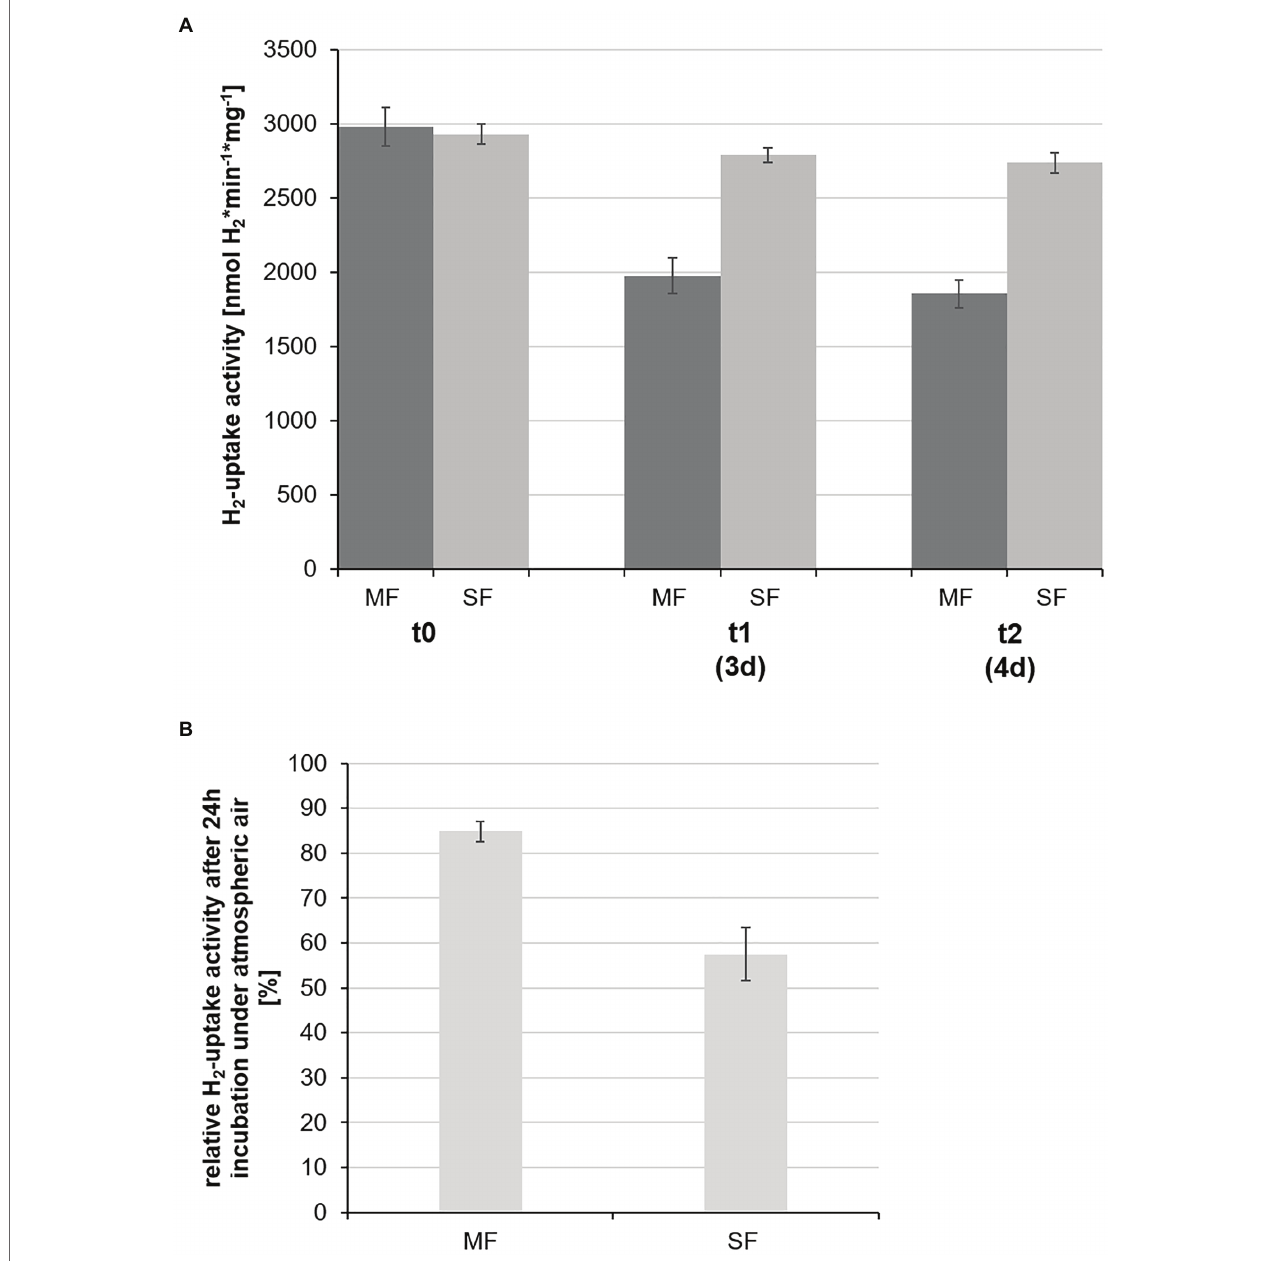
FIGURE 6 | Specific hydrogen uptake activities of the soluble (SF) and membrane (MF) protein fractions of strain KaireiS1. The measurements at the different time points (0, 3, and 4 days) were carried out using the same protein extracts, stored under oxygen-free conditions at 4 ° C (A) . The stability of the respective hydrogenases was also tested by incubating the protein extracts from day 3 for 24 h under atmospheric air at 4 ° C with the subsequent determination of the relative hydrogen uptake activities at time point t 2 (B) . Error bars indicate the standard deviations from three independent